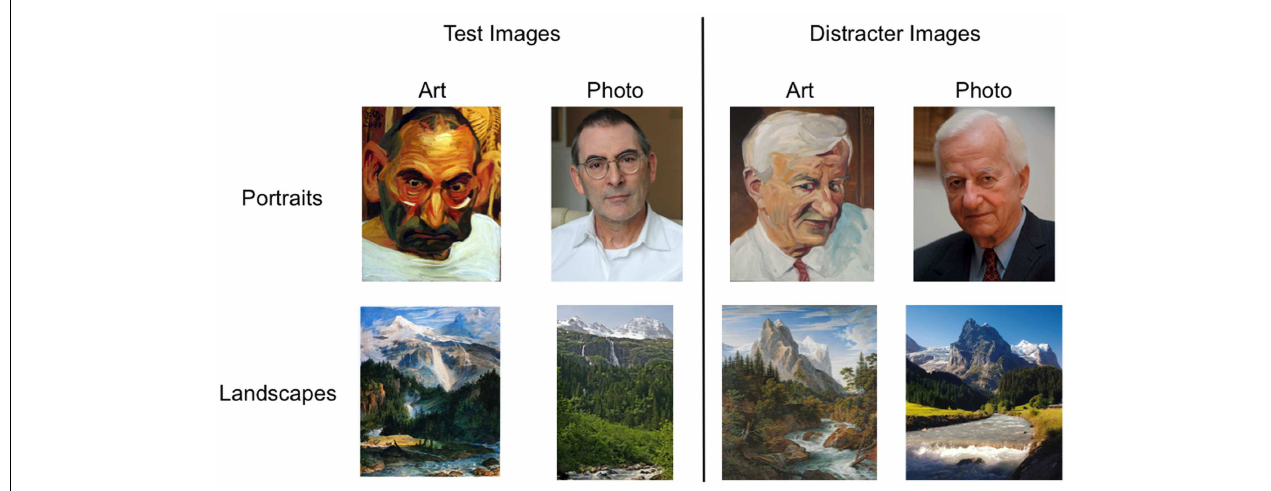
FIGURE 1 | Examples of stimuli used in the esthetic stability test (test images: P1, L5) and matched distracter images used in the explicit memory test (distracter images). Image metadata are provided in Table 1 .